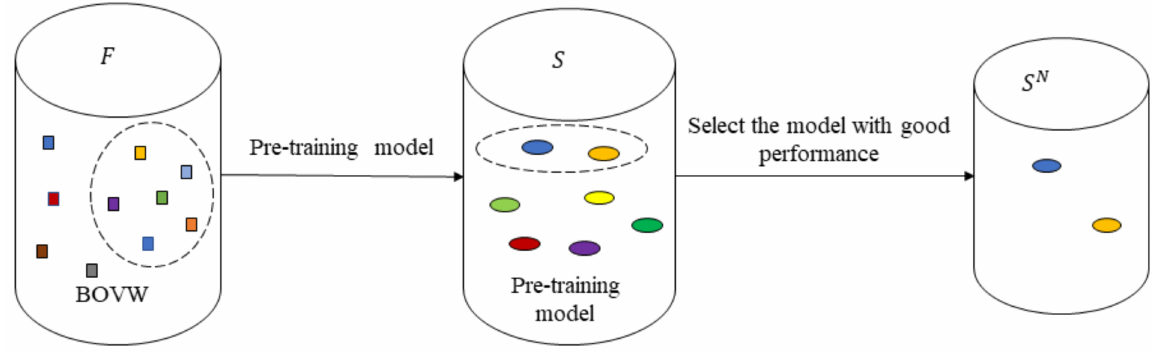
Figure 3. Flow chart of pre training